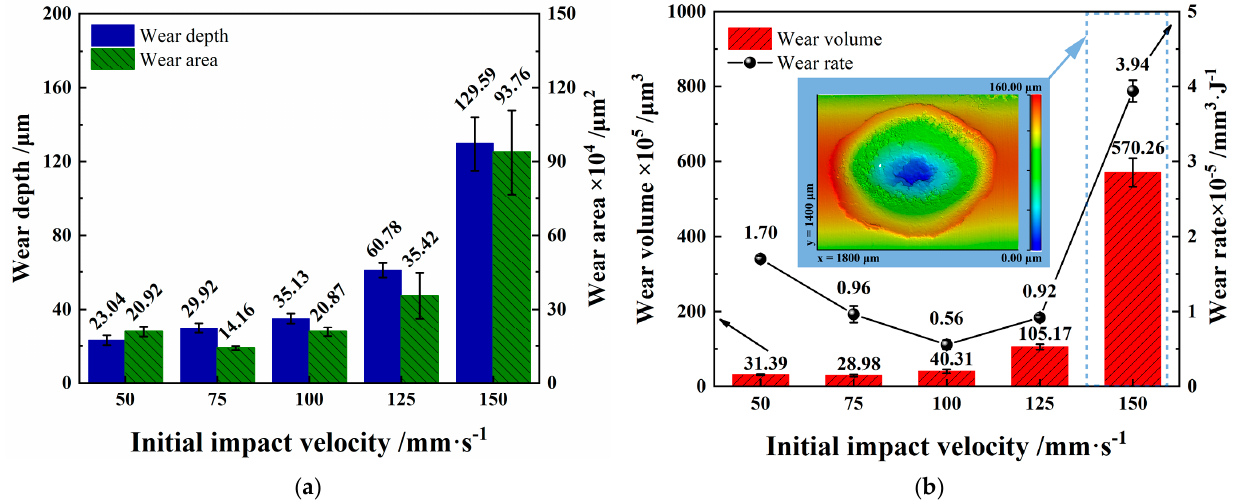
Figure 5. Wear statistics under varying initial impact velocities. ( a ) Wear depth and wear area; ( b ) wear volume and wear rate.